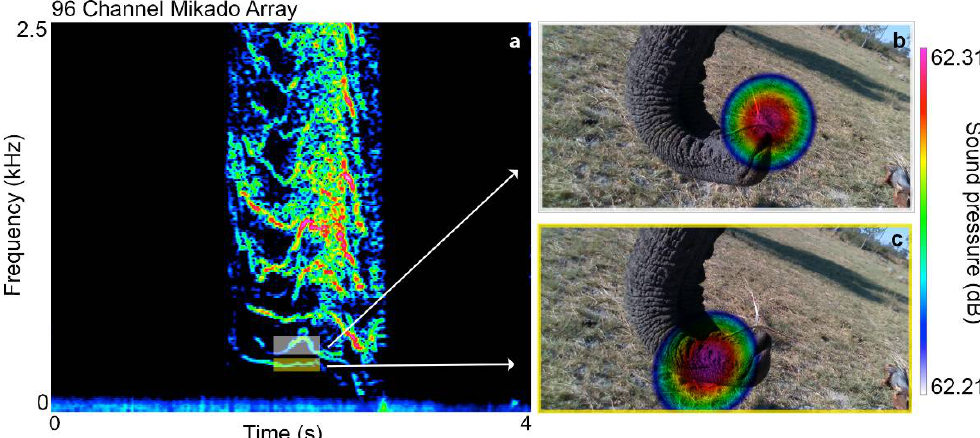
Figure 2. Biphonation in a high-frequency sound. Spectrogram ( a ) and sound visualizations ( b , c ) of a biphonation event in a HFS produced by Jabu, revealing that the two independent frequencies (yellow and white rectangle) are emitted via different nostrils.